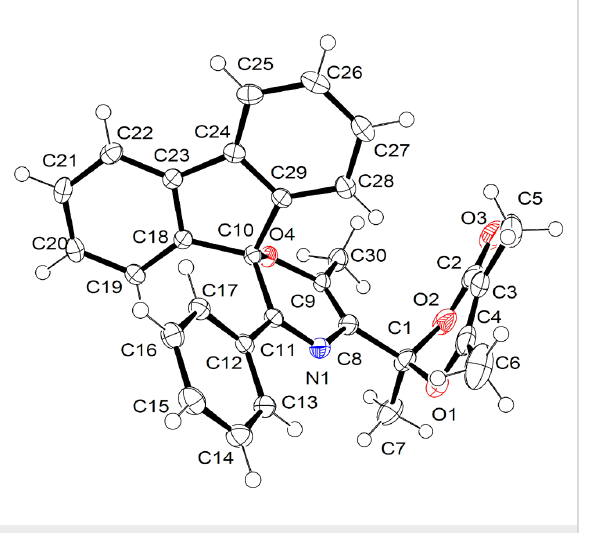
radiation in a CDCl 3 solution at room temperature they undergo a ring opening to yellow–orange azadienes 3f–i which cyclize back to oxazines 4f–i in the dark. The effect of the C5-substituent in 2 H -1,4-oxazine on its photochromic activity can be tracked by changes in the half-life times of open-chain isomers Z - 3a , Z - 3i and 19 (Scheme 7). It was found that the azadiene cyclization rate strongly depends on the electron-with- drawing ability of substituent R and increases as it changes from Ph or H to CO 2 Et or